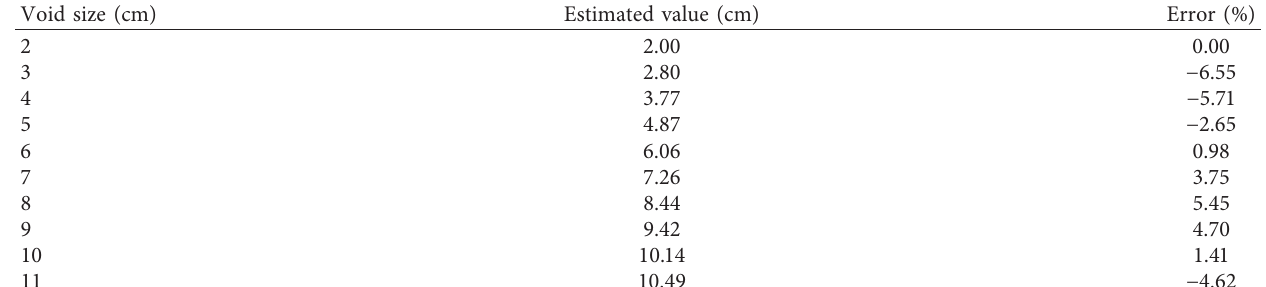
Figure 10: Void size-echo amplitude regression curve of plain concrete. Table 2: Void-size determination errors in plain concrete.